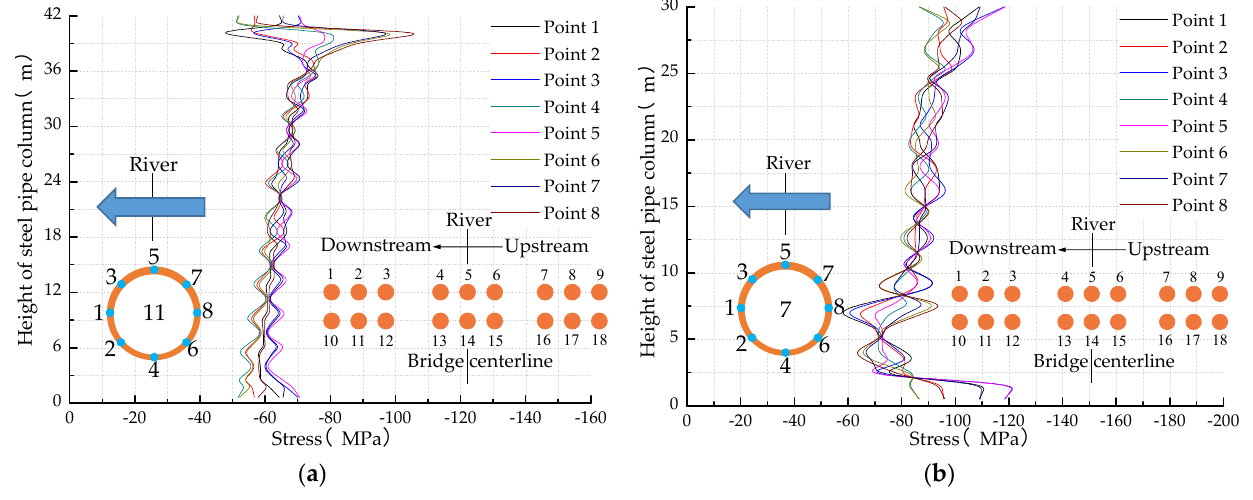
Figure 15. Normal stress of steel pipe column under each load condition. Eight feature points are marked on the steel pipe column cross-section, and the nor-